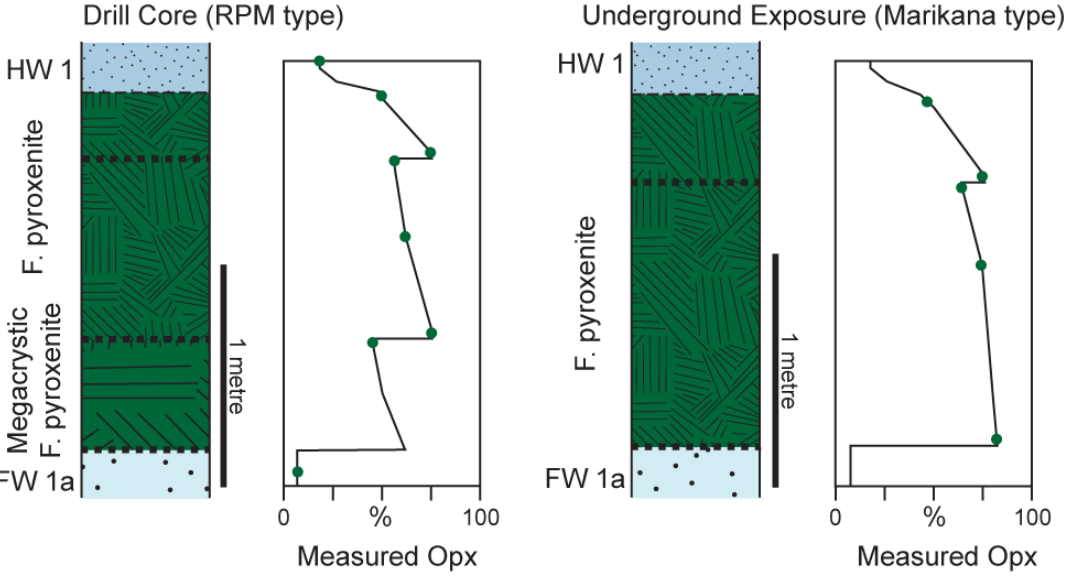
Figure 8. Variation of modal % orthopyroxene (Opx) with vertical height through the Merensky Reef. Modal percentage measured at sample points marked by green circles from hand-digitised texture maps and visually estimated throughout the remainder of the Merensky sequence. Note the abrupt increases above the chromitites (dashed black lines). Megacrystic F. pyroxenite = megacrystic feldspathic orthopyroxenite, F. pyroxenite = feldspathic orthopyroxenite.